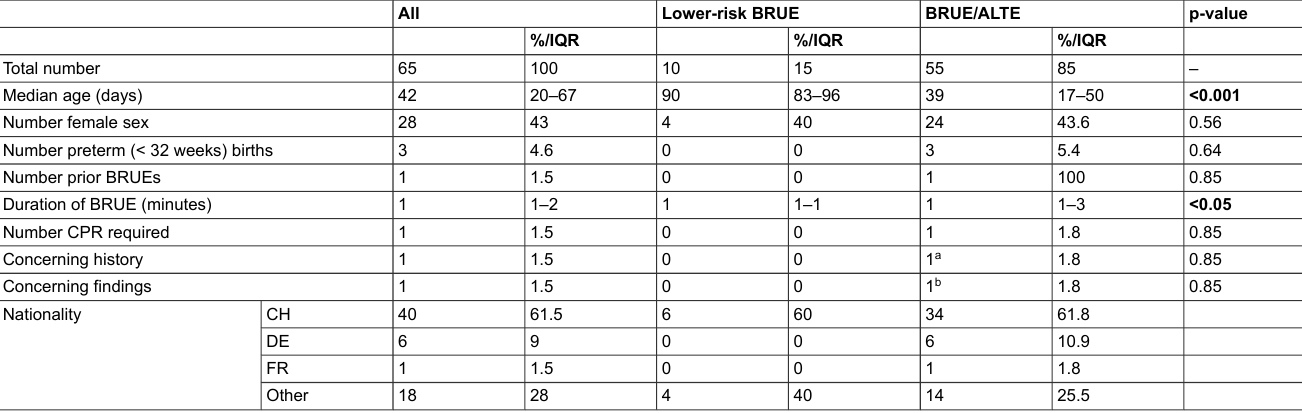
Table 2: Baseline characteristics of lower-risk BRUE and BRUE/ALTE patients.